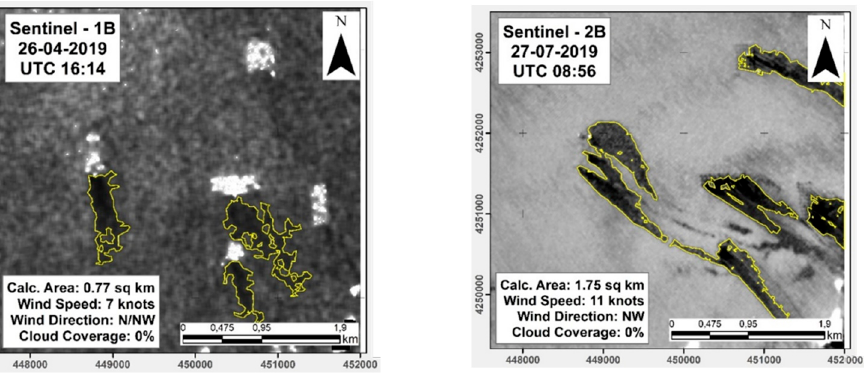
Figure 10. Two examples of true positive classifications with Sentinel-1 ( left ) and Sentinel-2 ( right ).